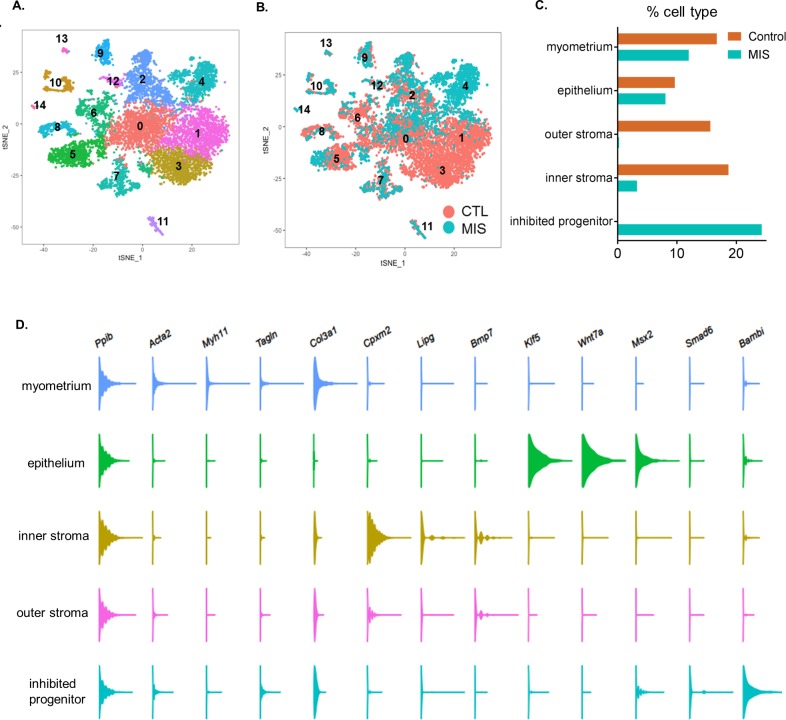
Single-cell RNA sequencing analysis of the control and AAV9-MIS treated rat uterine cells.(A) Rat pups were treated with empty vector control (CTL) or AAV9-MIS (MIS) on PND1, and euthanized on PND 6 (n = 3 for both). t-SNE plot displaying the results of unbiased clustering of single uterine cells, where each color-coded cluster represents one cell type/state (all clusters included). Labels are as follows: 0: censored, 1: outer stroma, 2: myometrium, 3: inner stroma, 4: inhibited cluster, 5: luminal epithelium, 6: dividing cells, 7: vascular endothelium, 8: dividing epithelium, 9: mesothelium, 10: myeloid, 11: erythroid, 12: pericyte, 13: lymphatic endothelium, 14: neurons (Figure 3—source data 1). (B) t-SNE plot displaying the clustering of single uterine cells where each dot/cell is color-coded according to treatment, either CTL (orange) or MIS (blue) (all clusters included) (Figure 3—source data 1). (C) Relative percentage of representation of cells by clusters based on treatment (CTL, orange and MIS, blue) in the main parenchymal uterine cell types (only the main uterine cell types are shown in Figure 3B). (D) Gene expression levels of selected markers in the main parenchymal uterine cell types.